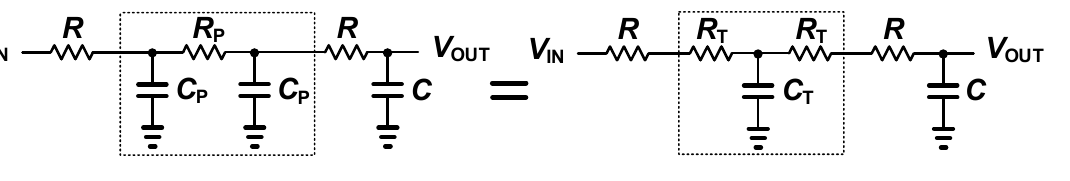
Figure 5. Lumped PI-T transform.